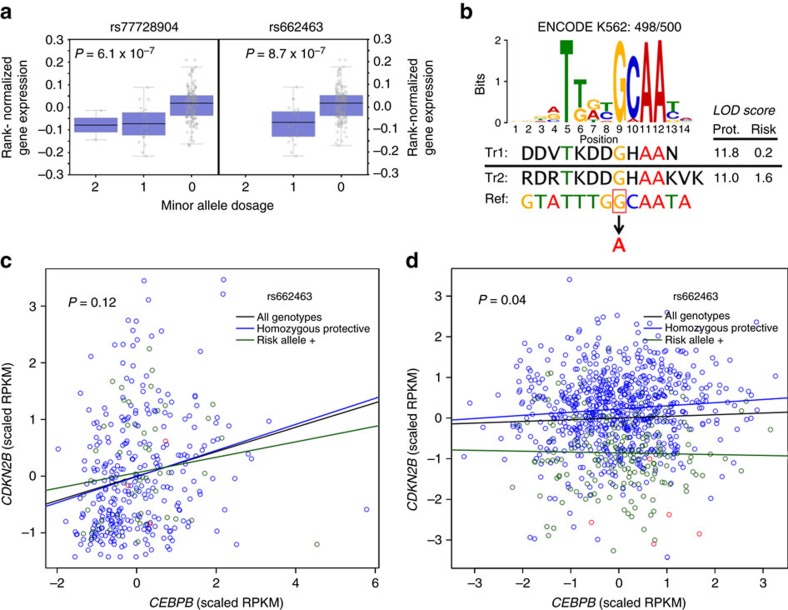
Multi-ethnic and functional analysis suggesting rs662463 is the causative BCP-ALL SNP tagged by the rs77728904-defined locus.(a) eQTL analysis from GTEx22 in whole blood showing the association of CDKN2B expression with rs77728904 and rs662463 genotypes. For both SNPs, the minor allele is the risk allele. Each grey circle represents an individual. Each box plot shows the median rank normalized gene expression (black horizontal line), the first through third quartiles (purple box) and 1.5 × the interquartile range (whiskers). (b) Motifs derived from ChIP data showing the effect of rs662463 on CEBPB binding. The genomic sequence (Ref) surrounding rs662463 is shown below the CEBPB-binding site motif logo for K562 cells from Factorbook27, with the reference protective G-allele boxed and the risk A-allele in red. The CEBPB motif logo represents the position weight matrix (PWM) for each base. The PWM LOD scores calculated by HaploReg24 from TRANSFAC28 for two CEBPB-binding motifs (‘Tr1' or TRANSFAC accession M00912 and ‘Tr2' or TRANSFAC accession M00109) including either the protective or the risk allele of rs662463 demonstrate that the risk allele disrupts CEBPB binding. (c) RNA-seq analysis in European ancestry LCLs29, suggesting that the rs662463 genotype influences the correlation between CDKN2B and CEBPB expression, and that the rs662463 risk allele is associated with lower CDKN2B expression. Shown are the best-fit lines overall (black line), for LCLs homozygous for the protective allele (blue line) and for LCLs with at least one copy (one copy: green circles and two copies: red circles) of the risk allele (green line). (d) RNA-seq analysis in whole blood from an independent set of European ancestry individuals23, demonstrating that the rs662463 genotype significantly influences the correlation between CDKN2B and CEBPB expression. The rs662463 risk allele attenuates this correlation and is associated with lower CDKN2B expression. Shown are the best-fit lines overall (black line), for individuals homozygous for the protective allele (blue line) and for individuals with at least one copy (one copy: green circles and two copies: red circles) of the risk allele (green line).